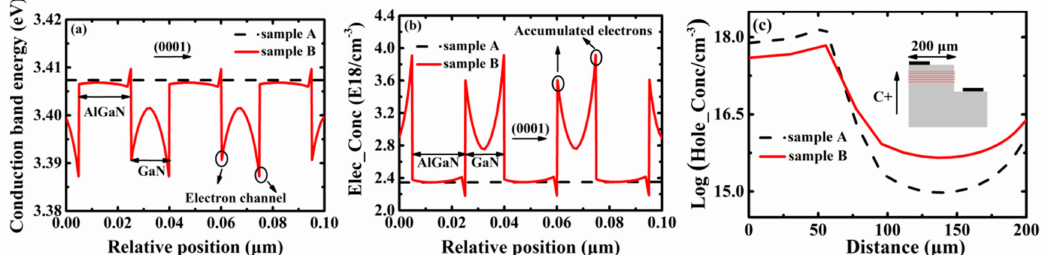
Figure 5. ( a , b ) are the calculated partial conduction band energy and electron concentration diagrams of both samples in the AlGaN / GaN structure; ( c ) is the hole concentration diagram along the x direction of both samples in the first quantum